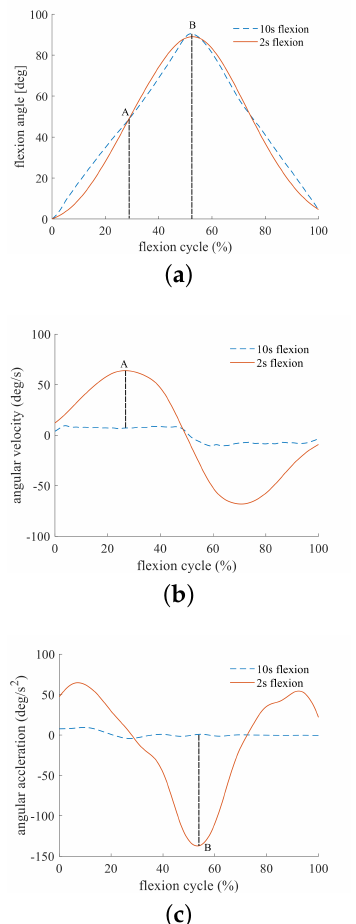
Figure 5. ( a ) Flexion angle versus flexion process for 2 and 10 s movements; “A” represents the greatest difference in angular velocity between 2 and 10 s, which is approximately 48 ◦ , and “B” represents the greatest difference in angular acceleration between 2 and 10 s, which is approximately 90 ◦ ; the flexion cycle is period that starts in an upright posture via flexion and ends in an upright posture again; ( b ) Trunk angular velocity versus flexion process for 2 and 10 s flexions; ( c ) trunk angular acceleration versus flexion process for 2 and 10 s flexions.